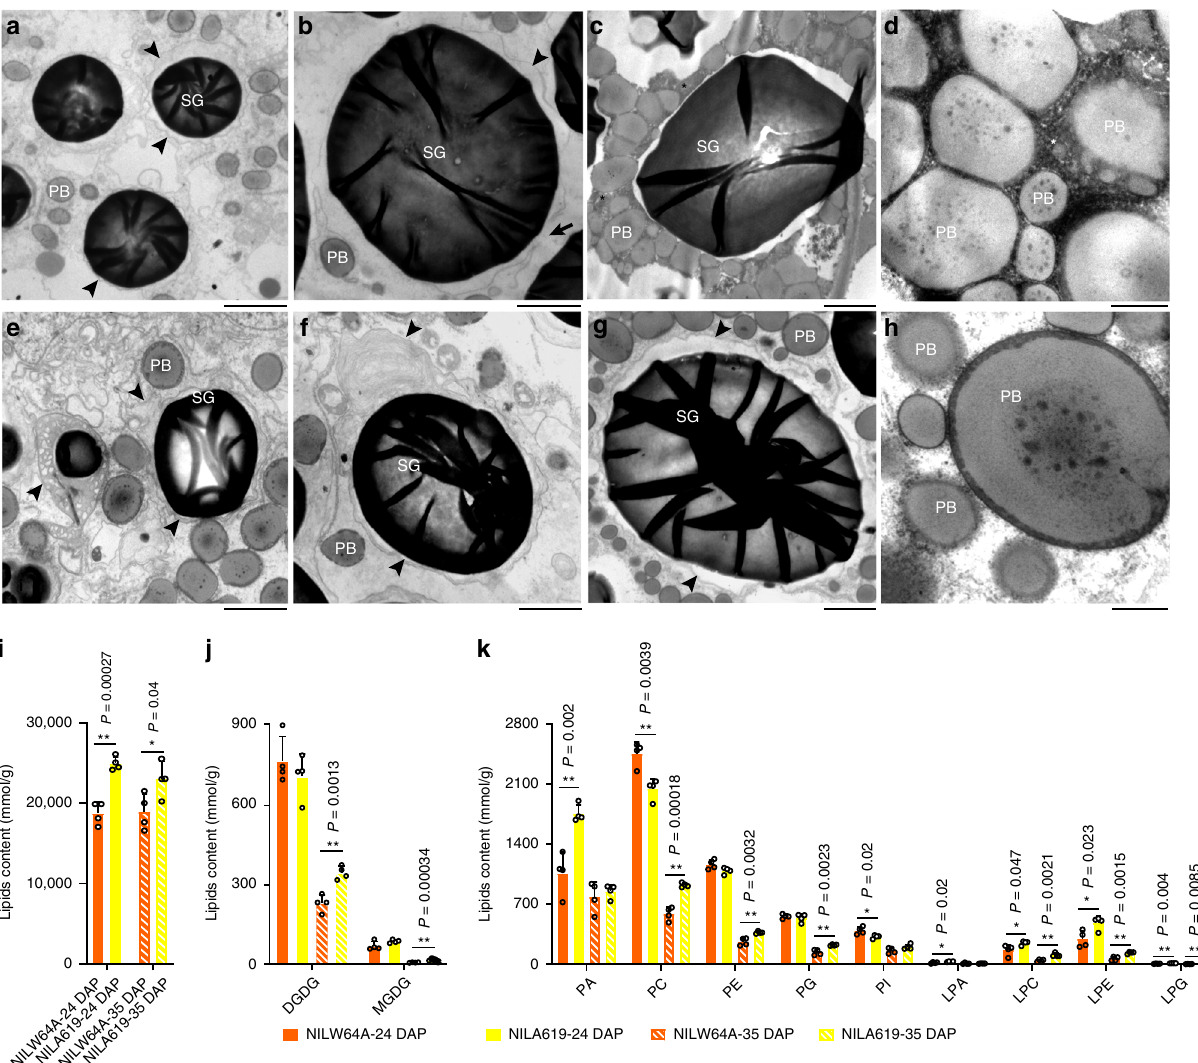
Fig. 3 Stability of PB membrane and the changes in lipid composition in endosperm of NILs. a NILW64A endosperm cell at 18 DAP. b NILW64A